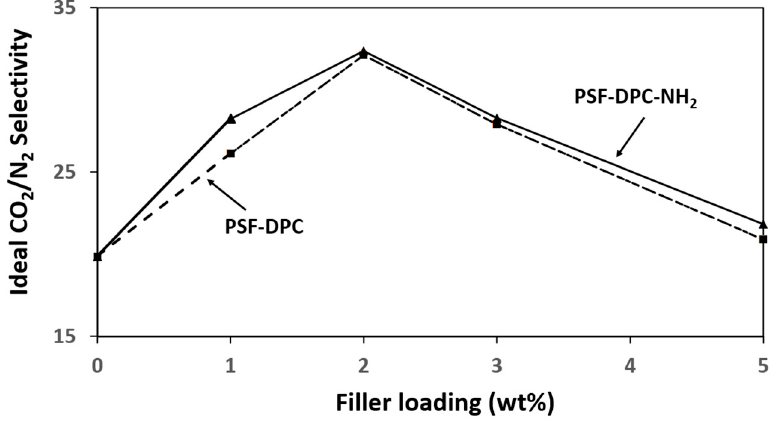
Figure 8. Ideal CO 2 /N 2 selectivity of the CMBs incorporated with different DPC and DPC-NH 2 loadings at a pressure difference of 4 bar.